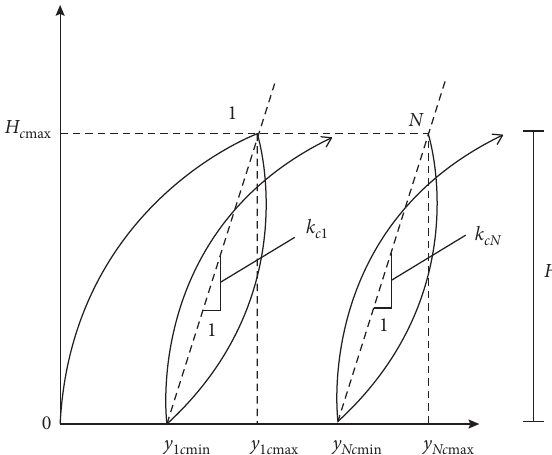
Figure 10: Calculation method of horizontal cyclic stiffness of single